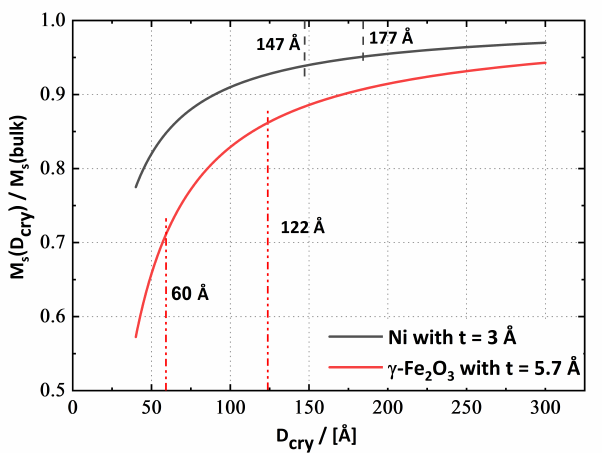
Figure 8. The influence of crystallite size on M S , according to [49], assuming a non-magnetic layer between adjacent crystallites of 5.7 Å for γ -Fe 2 O 3 and 3 Å for Ni. Due to the smaller CSDS for γ -Fe 2 O 3 the surface-to-volume ratio becomes larger, causing a stronger decrease of M S γ -Fe